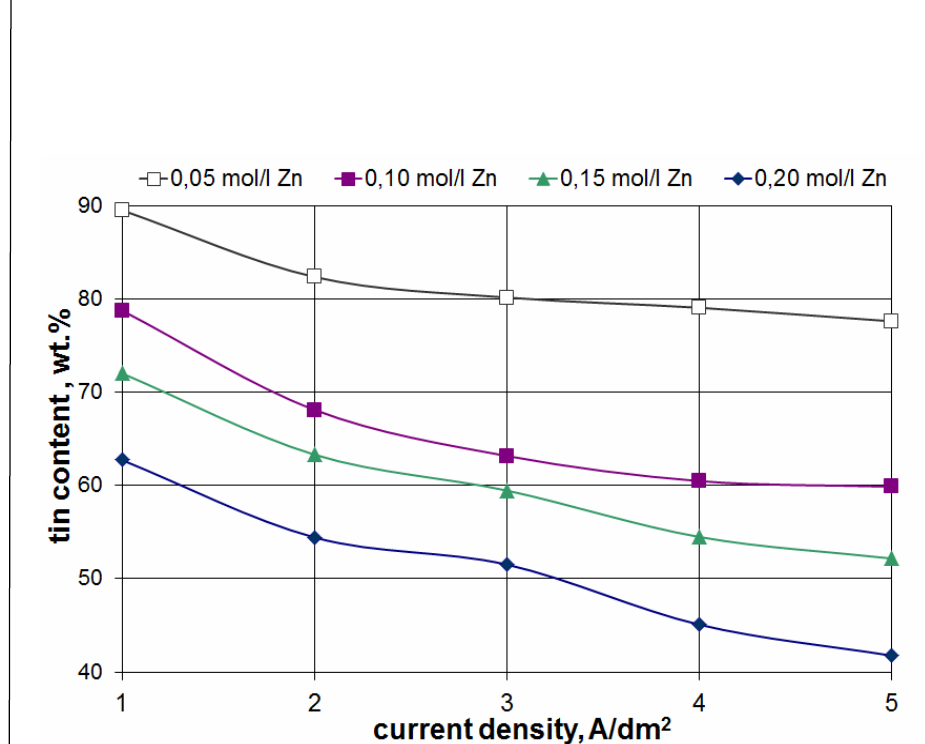
Figure 5 – Tin content in the Sn-Zn layers, depending on the zinc content in the bath and current density, at 60°C; pH = 9.3 with 0.05 mol/l Sn, c(P2O74-)/ c(Sn2+ + Zn2+)= 2.5 and 1 g/l gelatine; 1 A, 20 min. Рис . 5 – Содержание олова в покрытии Sn-Zn, зависит от содержания цинка в ванной и плотности токана 60°C; при значении pH = 9.3 с 0.05 mol/l Sn, c(P2O74-) / c(Sn2+ + Zn2+)= 2.5 и 1g/l желатина ; 1 A, 20 мин